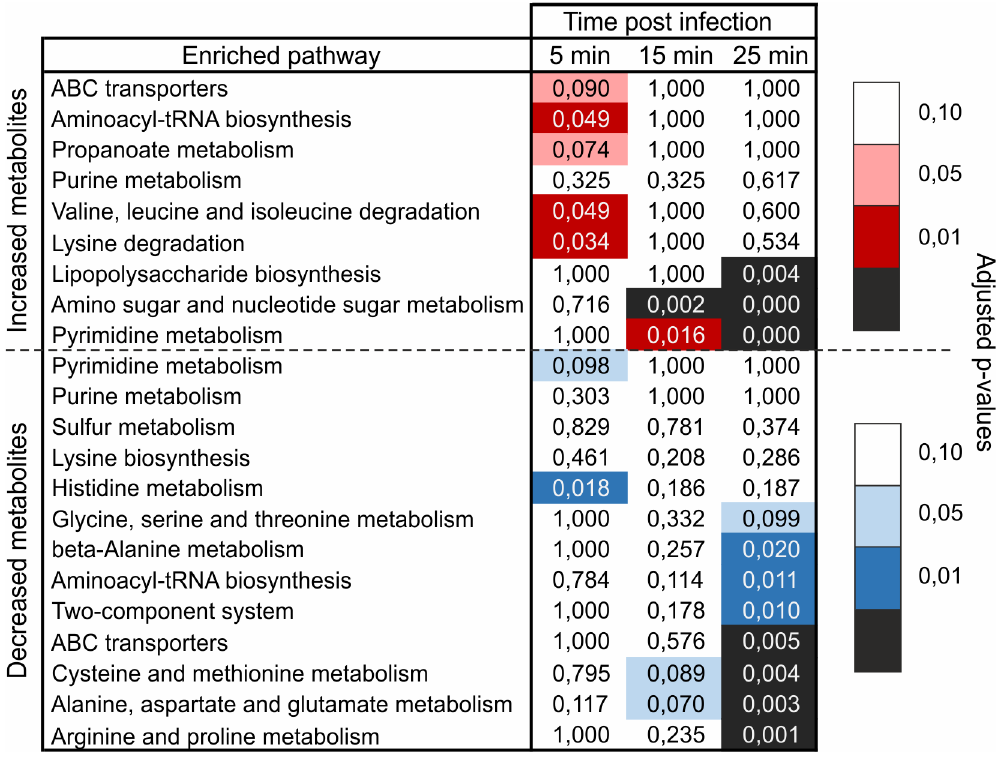
Fig 5. Pathway enrichment analysis during PAK_P3 infection revealed its requirement on pyrimidine metabolism. Values of the enrichment analysis are shown for the significantly enriched pathways (rows) at the different time points (columns). The color scale indicates the cut-off for the p-values, where red and blue are used for, respectively, the pathways found enriched among increased and decreased metabolites.